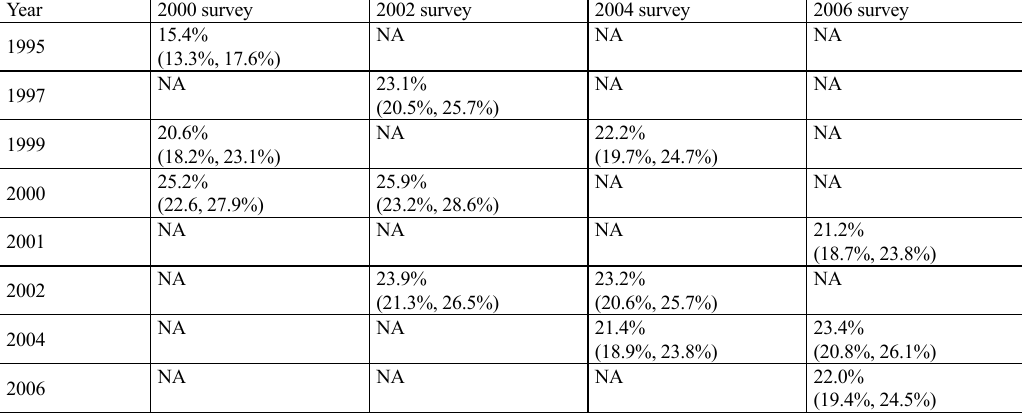
Table 2 : Tax Evasion Rates and Confidence Intervals for the 2000, 2002, 2004, and 2006